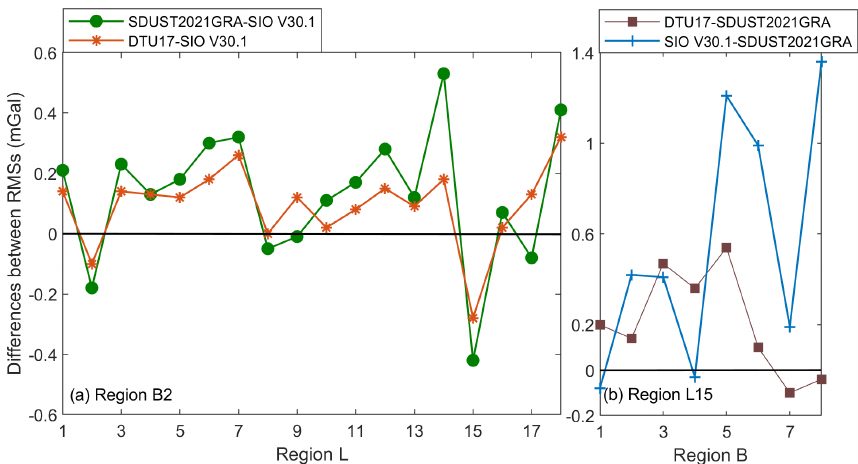
Figure 10. Differences between RMSEs. The RMSEs are statistics of differences between altimeter-derived gravity models and shipborne data: (a) for region L1B2, L2B2, ... , L18B2; and (b) for region L15B1, L15B2, ... , L15B8. Table 3. Statistics of differences between altimeter-derived and shipborne gravity data in different areas (unit: mGal). Min Max